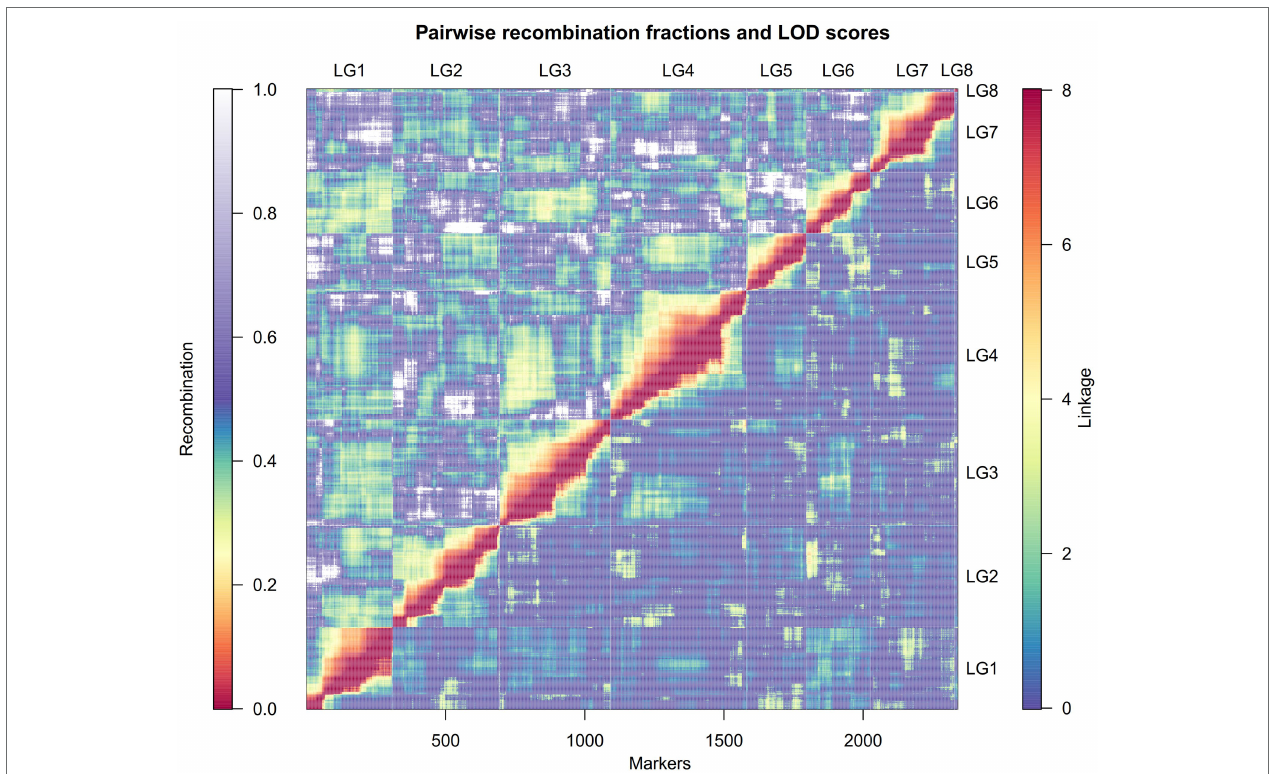
FIGURE 2 | A heatmap demonstrating the estimated recombination fractions and corresponding linkage between the markers in each of the linkage groups. The upper half of the matrix (left and above the diagonal) represent the recombination fraction, with color scale from red (lowest recombination) to purple-white (highest recombination). The bottom half of the matrix (right and below the diagonal) represent the linkage (in LOD score) between each marker pair, with color scale from blue (lowest linkage) to red (highest linkage). The x-scale shows the number of